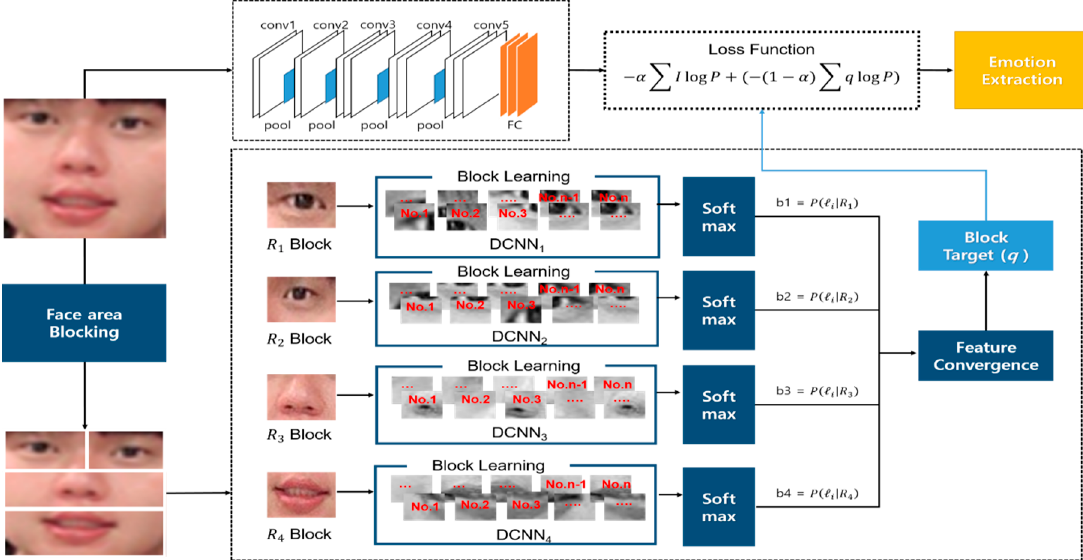
Figure 10. The proposed multi-block deep learning structure. * The figure included in this image is the author, who agreed to provide the